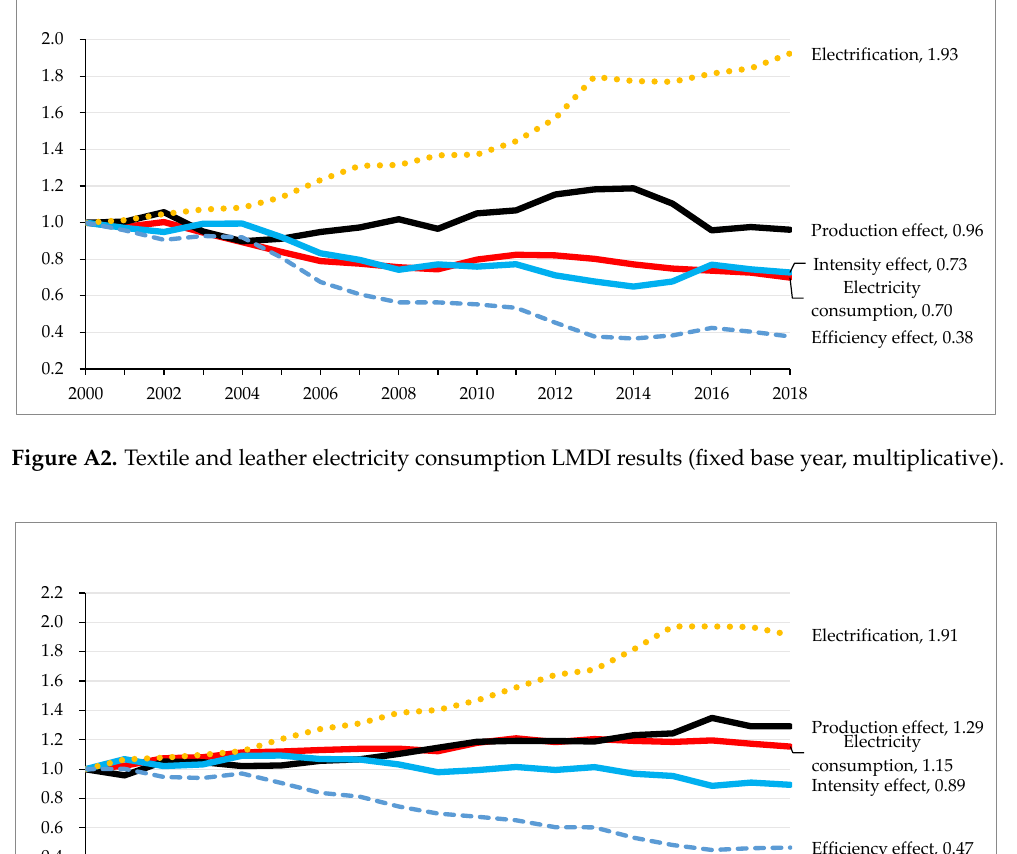
Figure A1. Food and tobacco electricity consumption LMDI results (fixed base year, multiplicative).